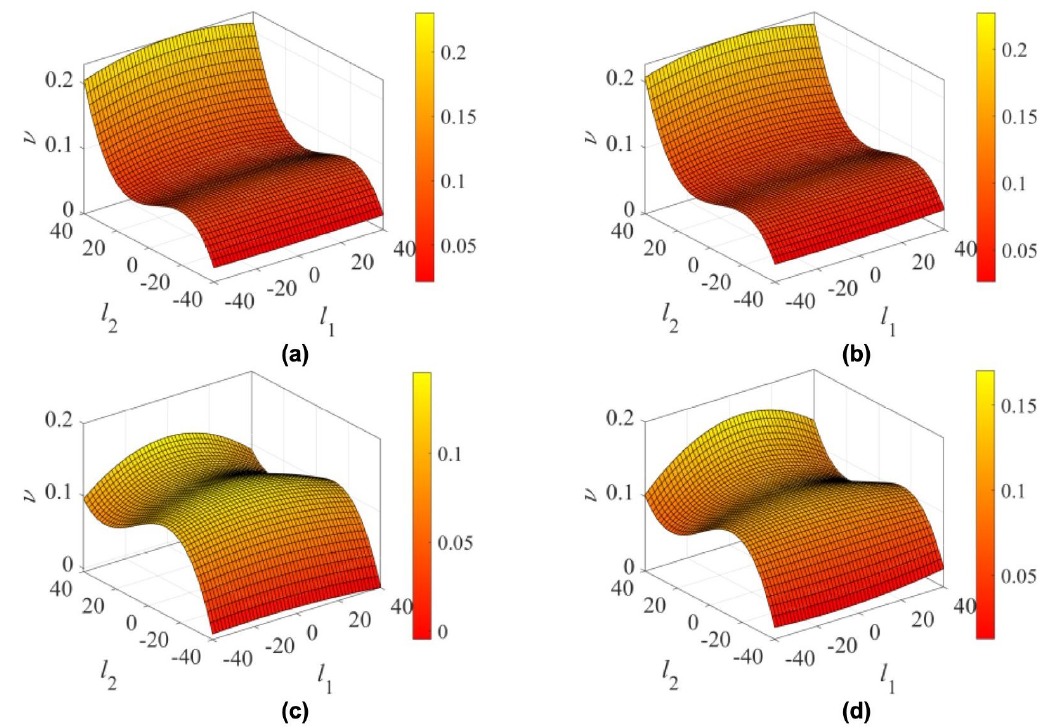
Figure 8: Pressure mode #1 for square plan with θ = 0 ∘ and geometry G 1 (a), G 2 (c), G 3 (b), G 4 (d), referring to Table 1